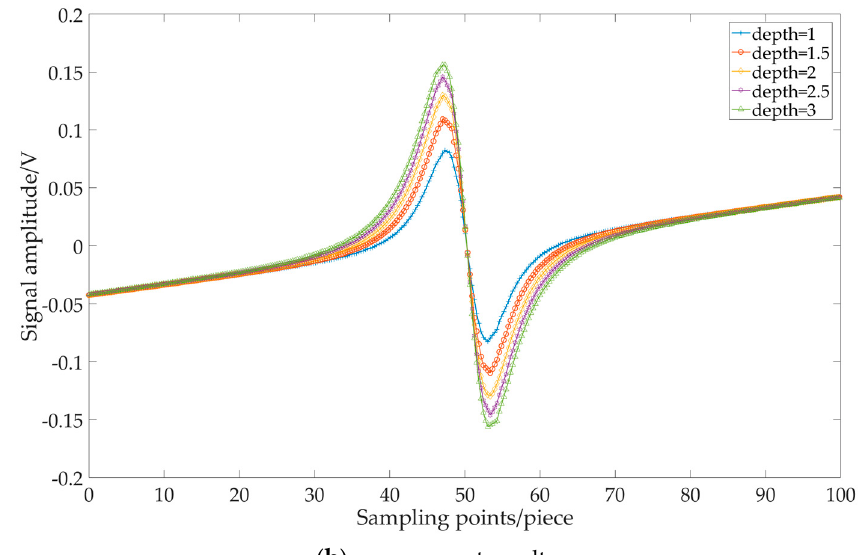
Figure 5. Results with different depths.